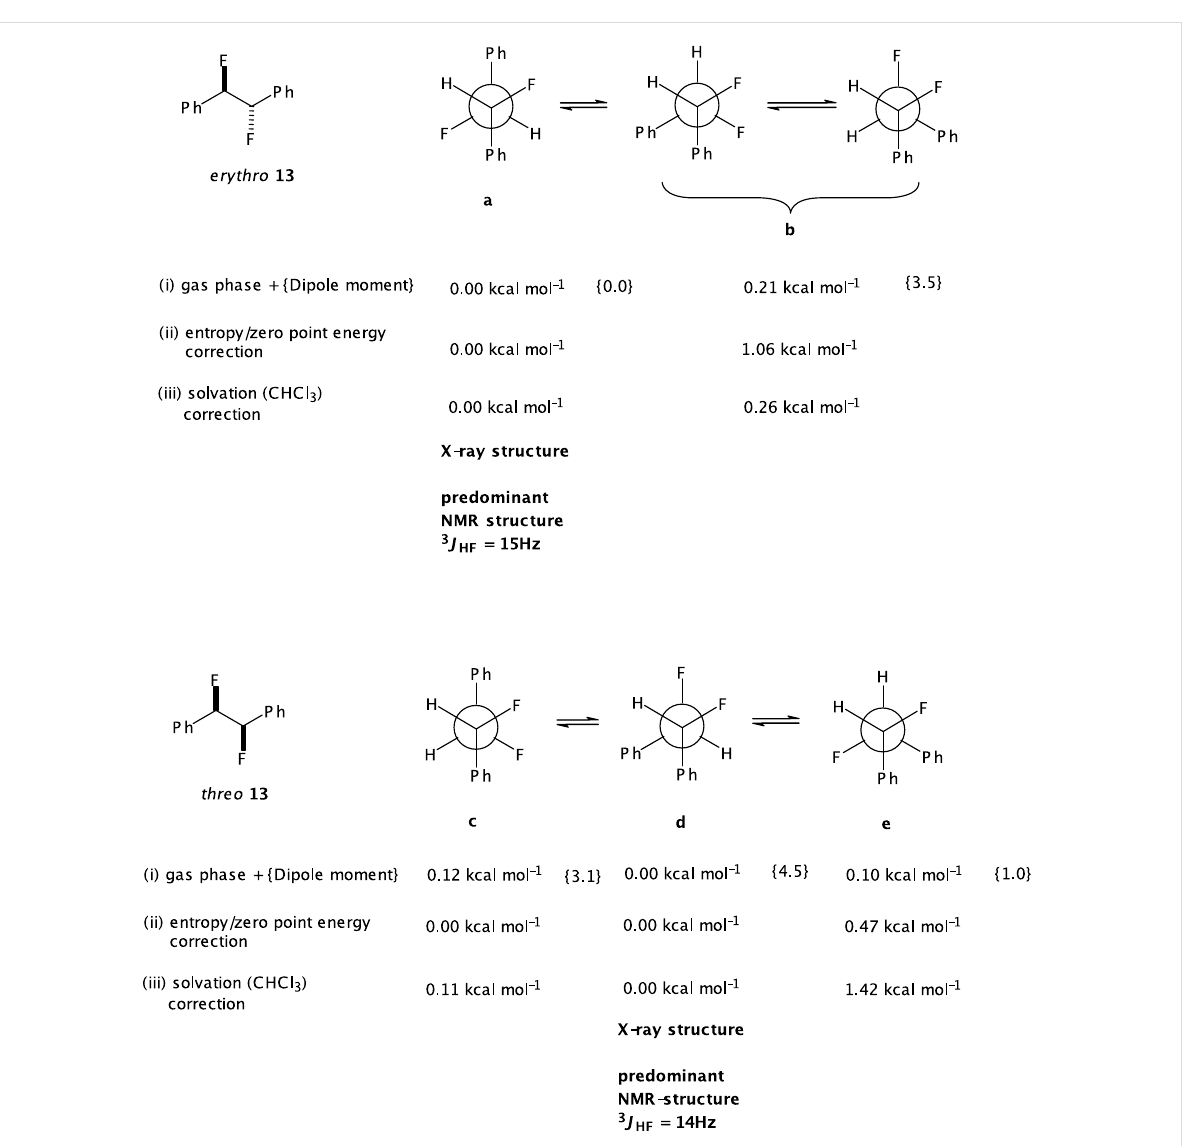
Figure 4: NMR coupling constants and calculated relative energies (kcalmol -1 ) of the staggered conformers of erythro - and threo - 13 calculated at the B3LYP//cc-pVTZ level. Relative energies (i) in the gas phase (ii) corrected for entropy and zero point energy differences and (iii) using a solvation model are reported. Calculated dipole moments {μ} are also